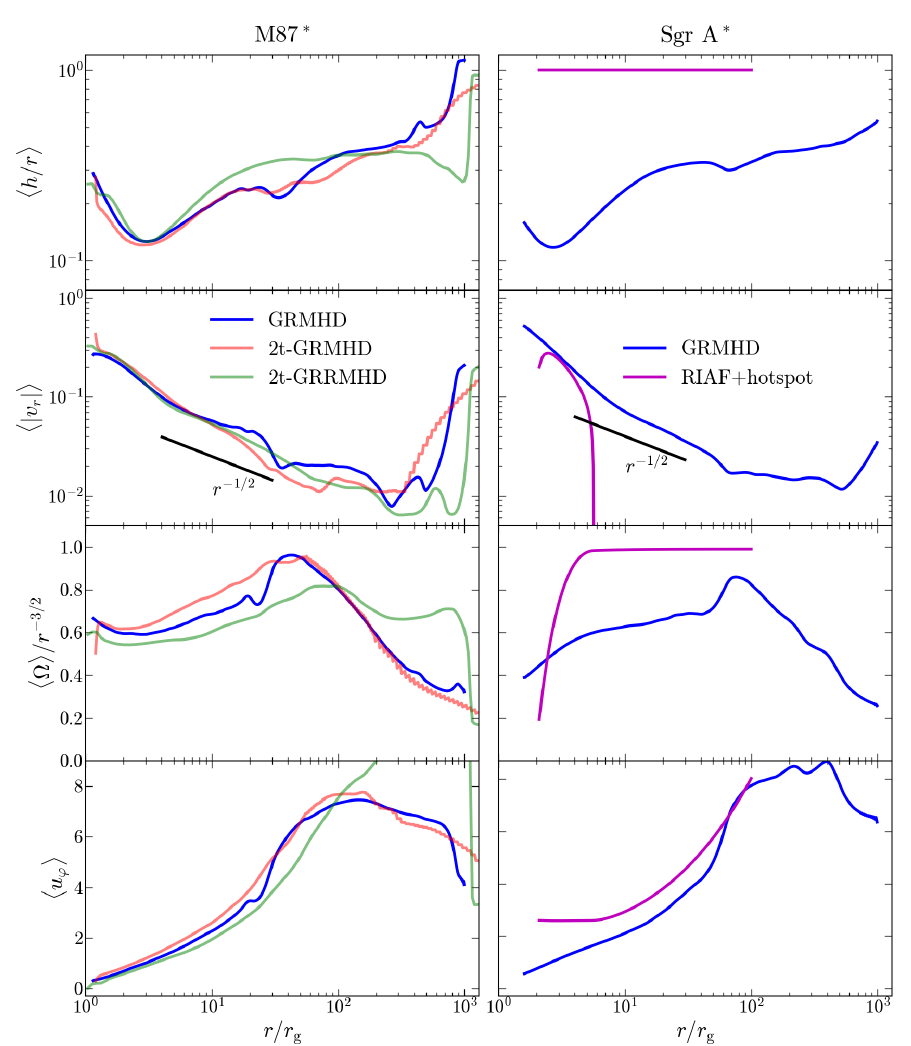
Figure 4. We show the radial profiles of disk scale height h / r , radial velocity | v r | , angular velocity Ω , and specific angular momentum u ϕ . Quantities are disk-averaged and time-averaged over the raytracing